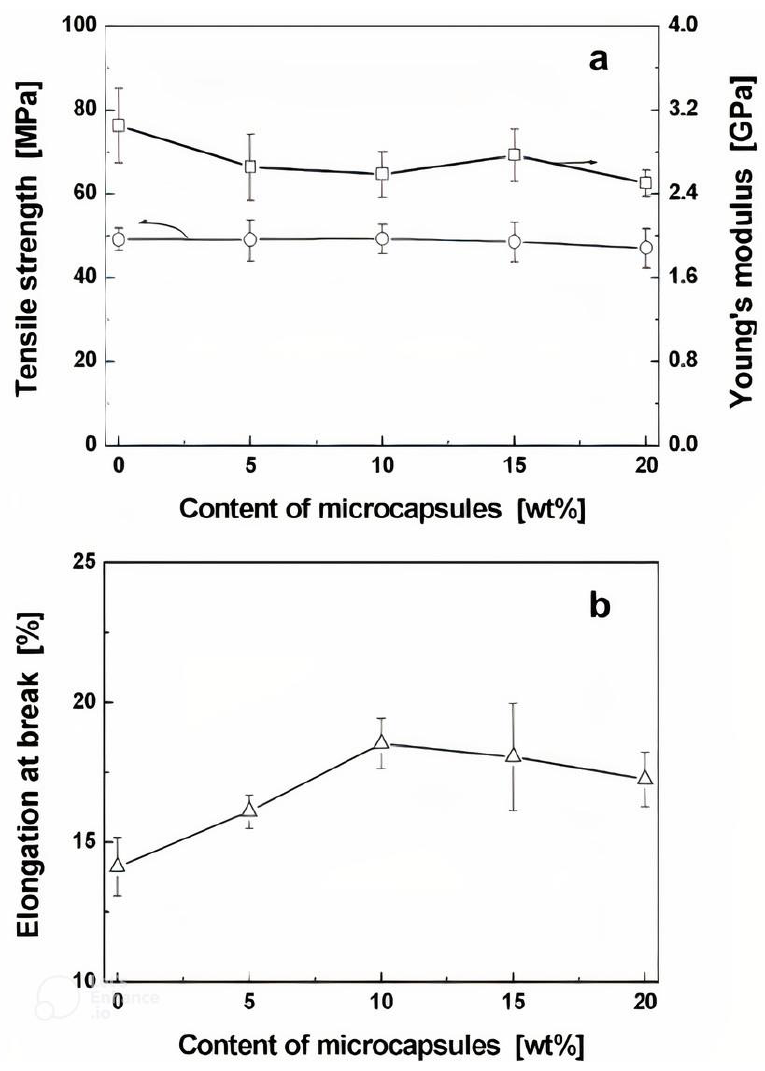
Figure 19. Variation in Tensile strength ( a ) and Elongation at break ( b ), as the microcapsules content increases [202].